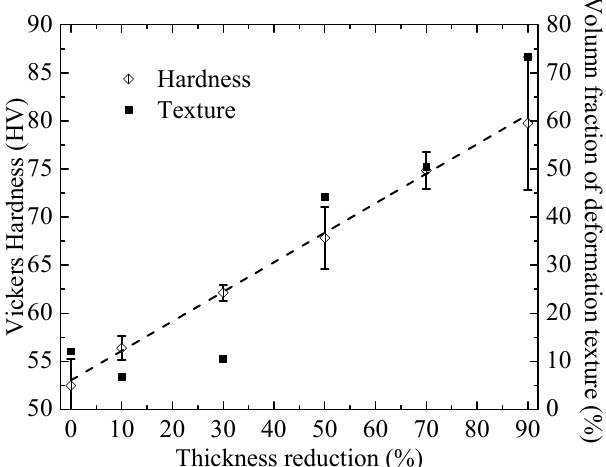
Figure 6. Dependence of the Vickers hardness on the thickness reduction for the indentation of the as-annealed and cold-rolled specimens at the normal load of 200 mN.